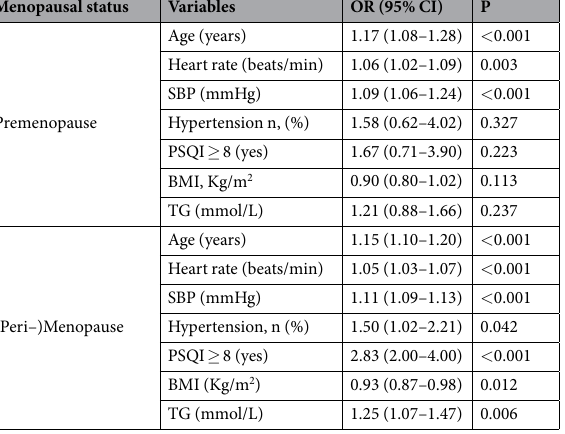
Table 4. Independent risk factors for arterial stiffness by menopause in a multi –covariates adjusted model. Covariates: BMI, WHR, SBP, DBP, PP, hypertension, diabetes mellitus, TG, TC, HDL, LDL, FBG, menopause, income, employment status, parity. OR, Odds ratio; CI, confidential interval. Only displayed p <